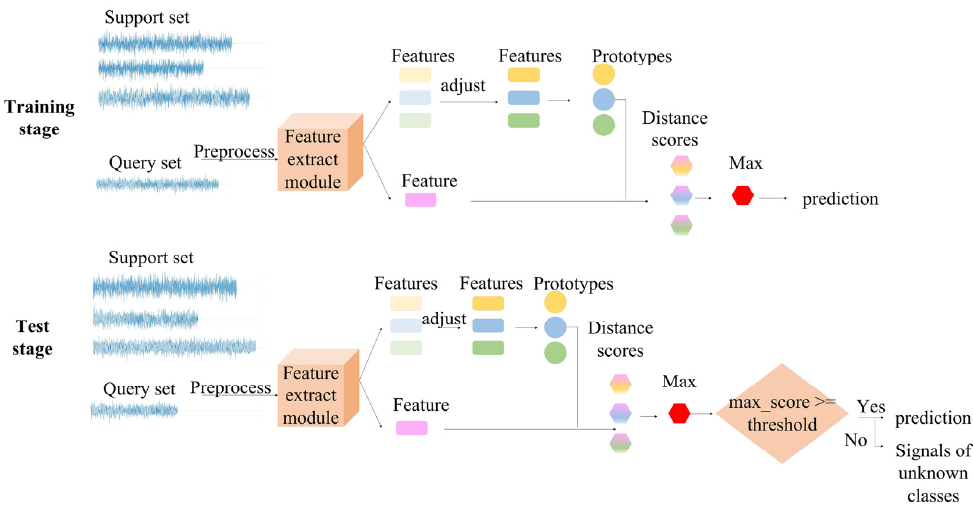
Figure 1. The overview of the IPN.